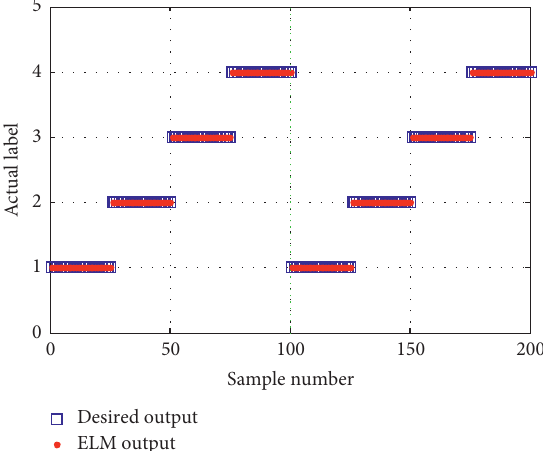
Figure 19: Classification results of the first trial of the proposed approach in case